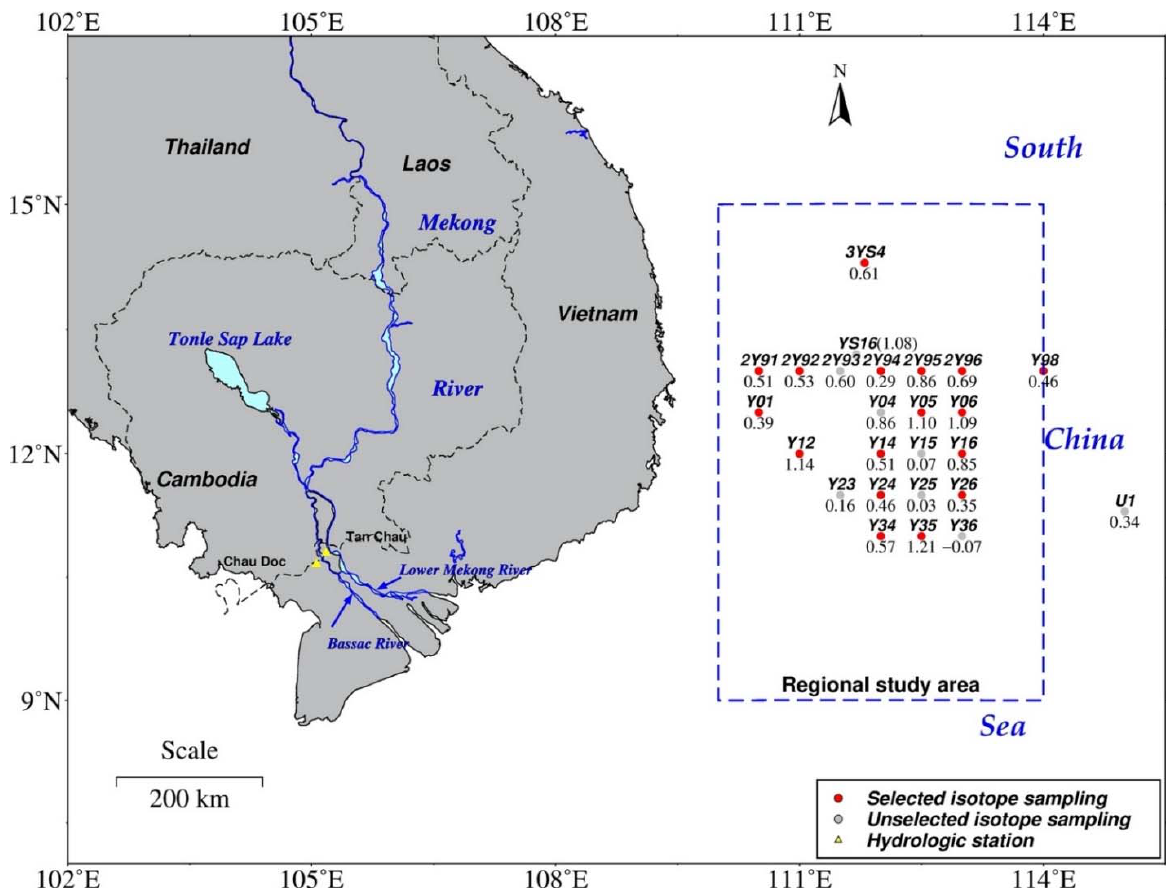
Figure 1. Lower Mekong basin and southern SCS. Dashed boundary (on the right) is our regional study area with selected (red dots) and unselected (grey dots) isotope samplings, along with their sampling codes (above the dots) and age (in month) (below the dots) (adapted with permission from ref. [9], Copyright 2010 American Geophysical Union).